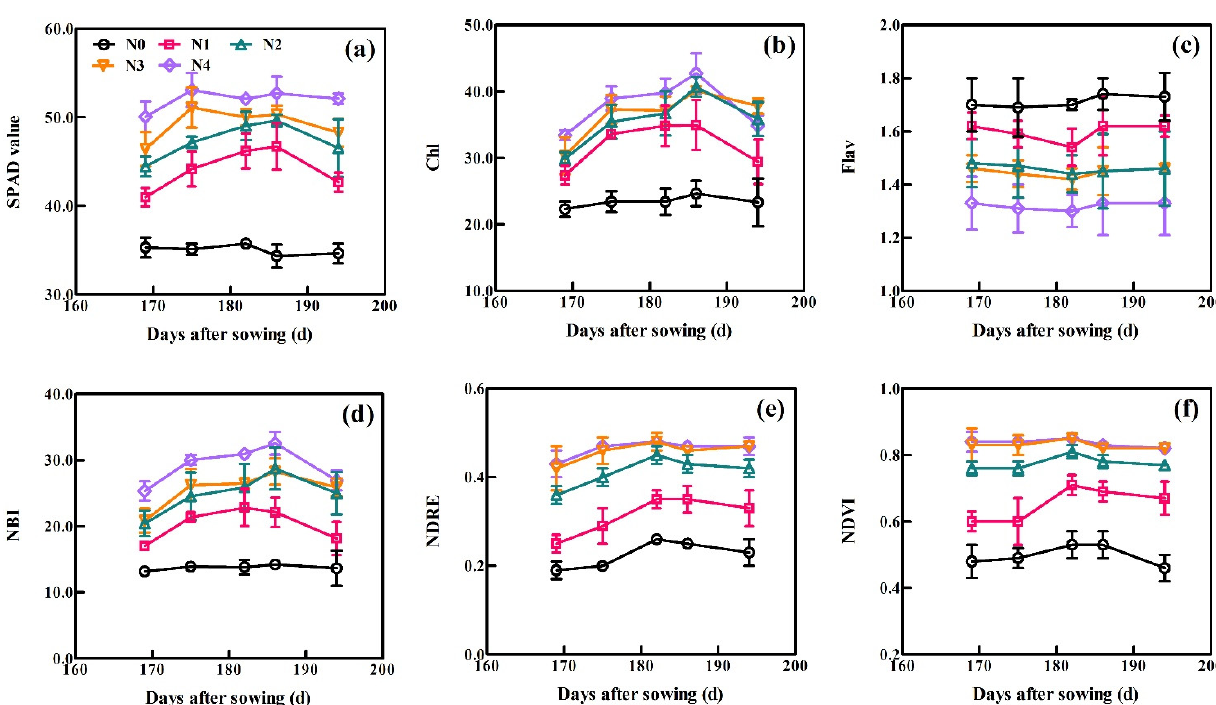
Figure 3. Dynamic variation in ( a ) SPAD, ( b ) chl, ( c ) Flav, ( d ) NBI, ( e ) NDRE, and ( f ) NDVI at the indicated days after sowing (DAS). Data were obtained from Experiment 1 using the XM30 cultivar. Vertical bars at each growth stage represent the standard error.